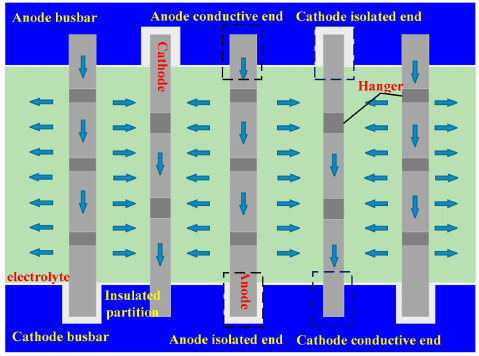
Figure 2. Current distribution of conductive copper rods.